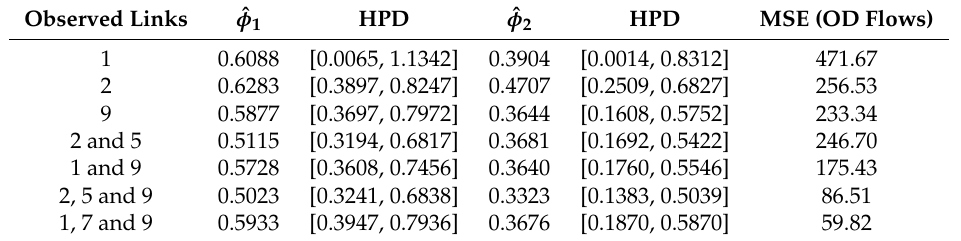
Table 3. Estimation results with observation on partial links (HPD—95% highest posterior density region). Observed